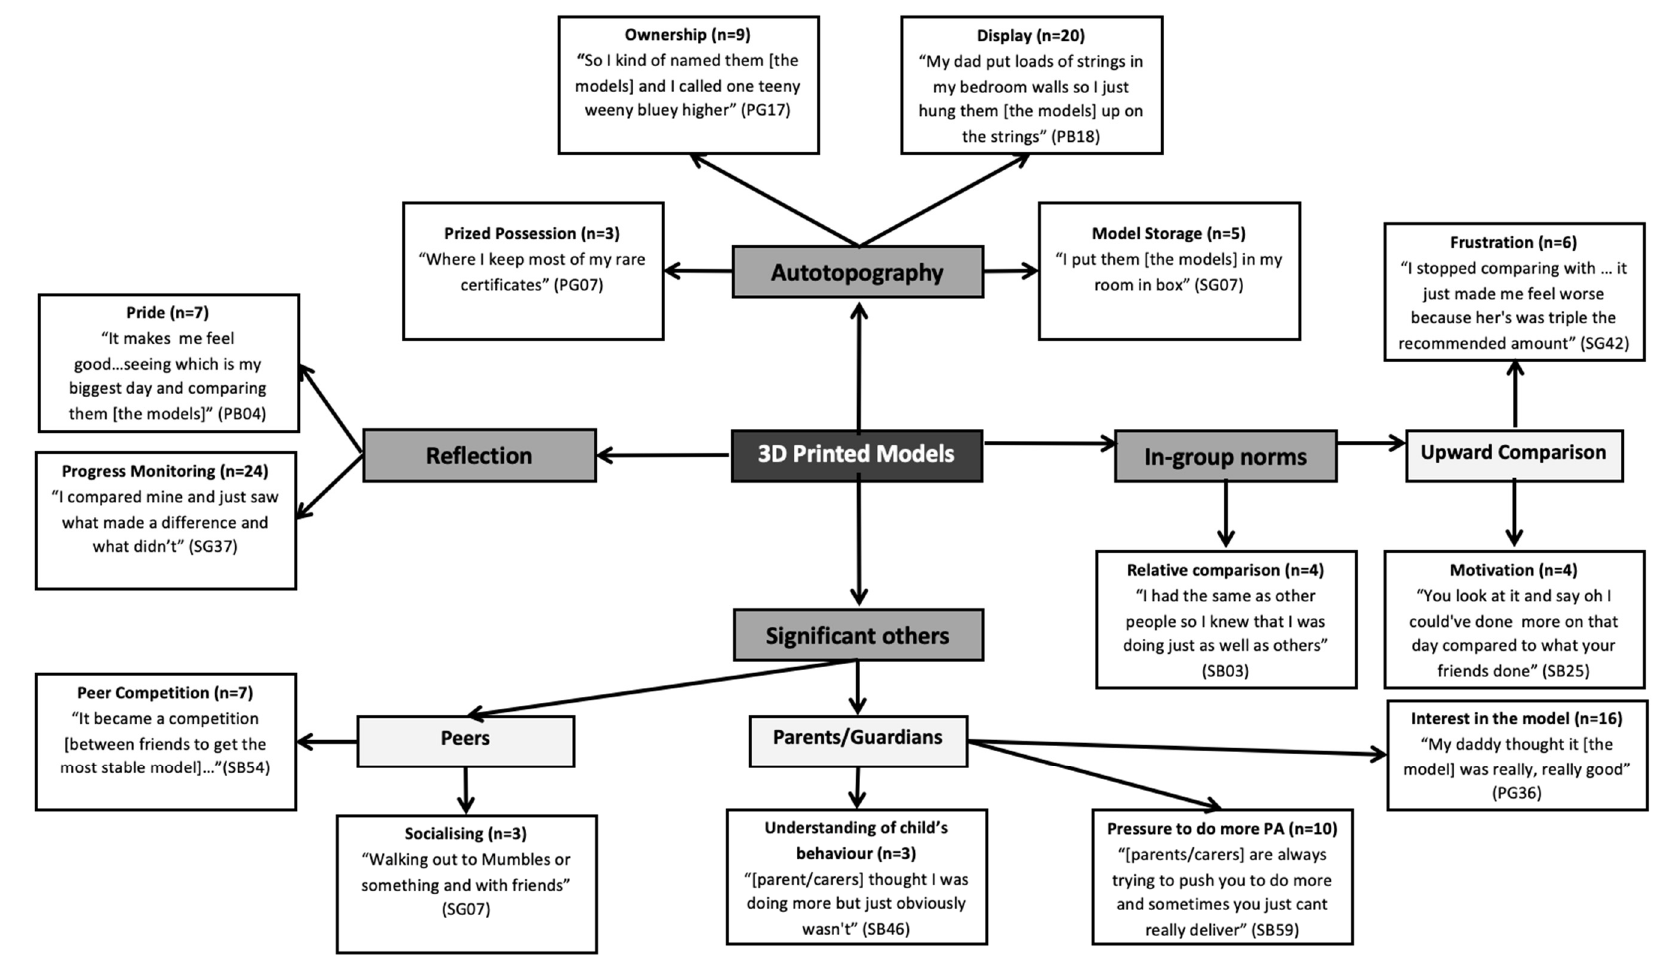
Figure 2. Pen profile representing youth’s interactions with the 3D models.